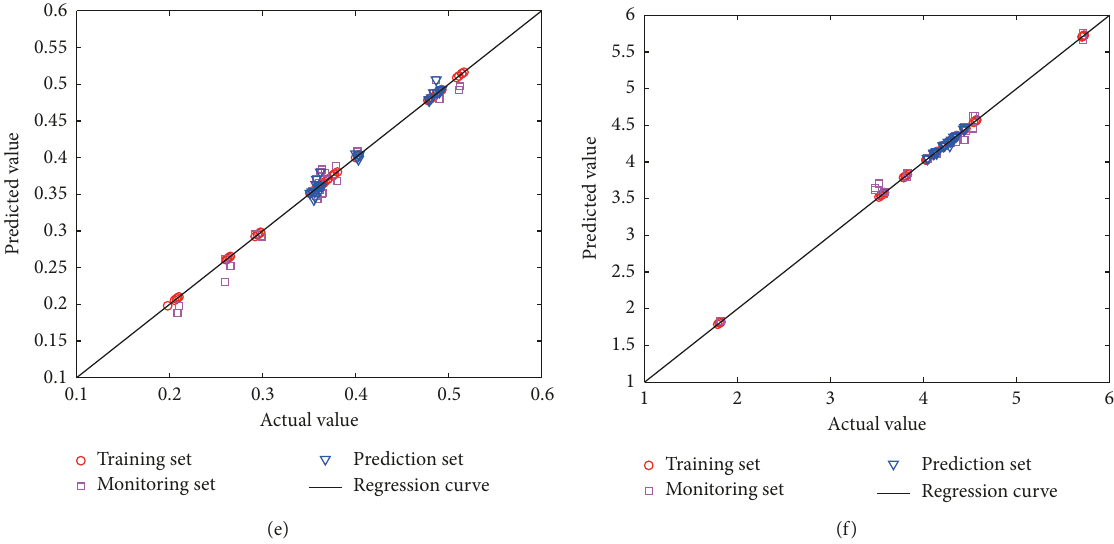
Figure 6: Correlation plots of the predicted antioxidant activities obtained by OSWLS-SVM versus the actual antioxidant activities in 12 famous green teas: (a) DPPH scavenging activity estimated by MIR model; (b) ABTS radical scavenging activity estimated by the NIR model; (c) DPPH scavenging activity estimated by the MIR model; (d) ABTS radical scavenging activity estimated by NIR model; (e) DPPH scav- enging activity estimated by the spectroscopic data fusion model; (f) ABTS radical scavenging activity estimated by the spectroscopic data fusion